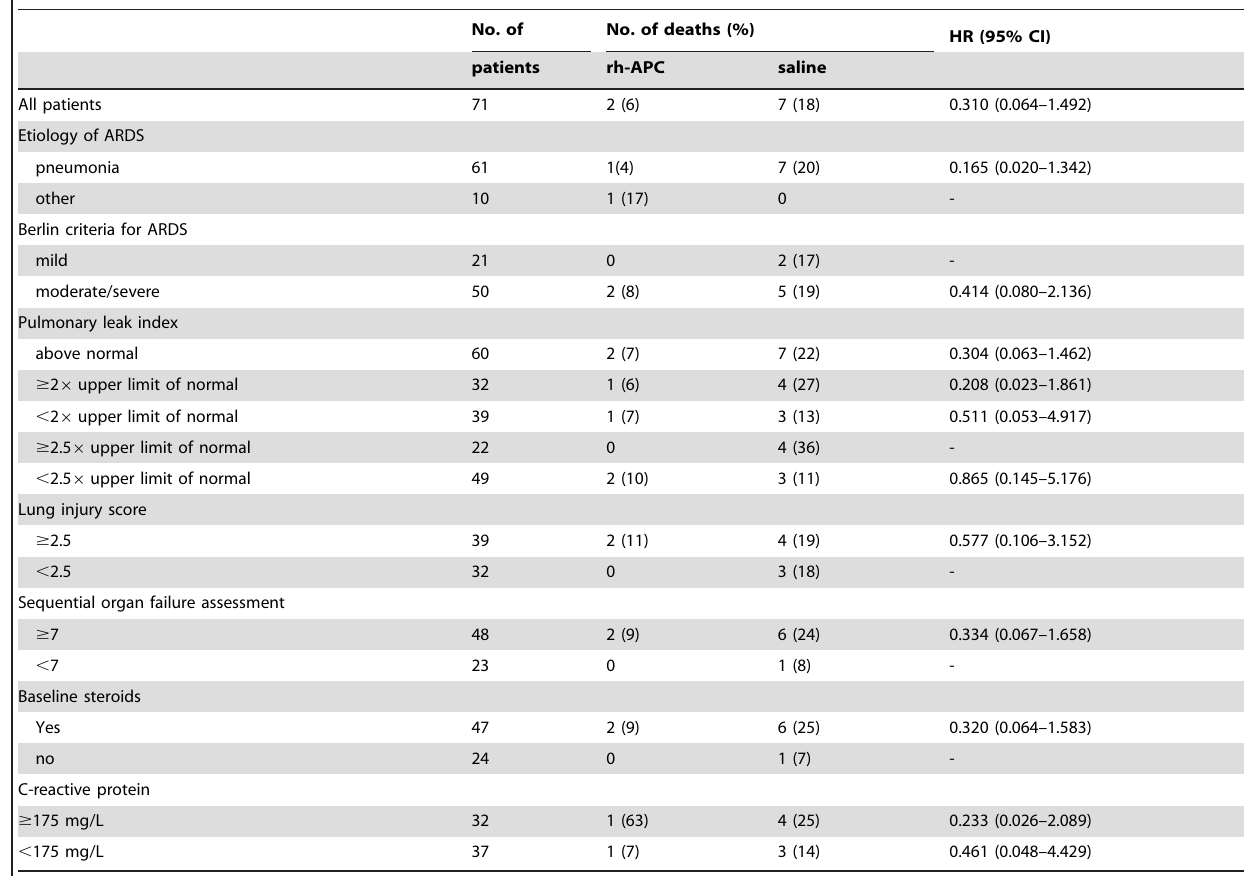
Table 4. Hazard ratios for death on day